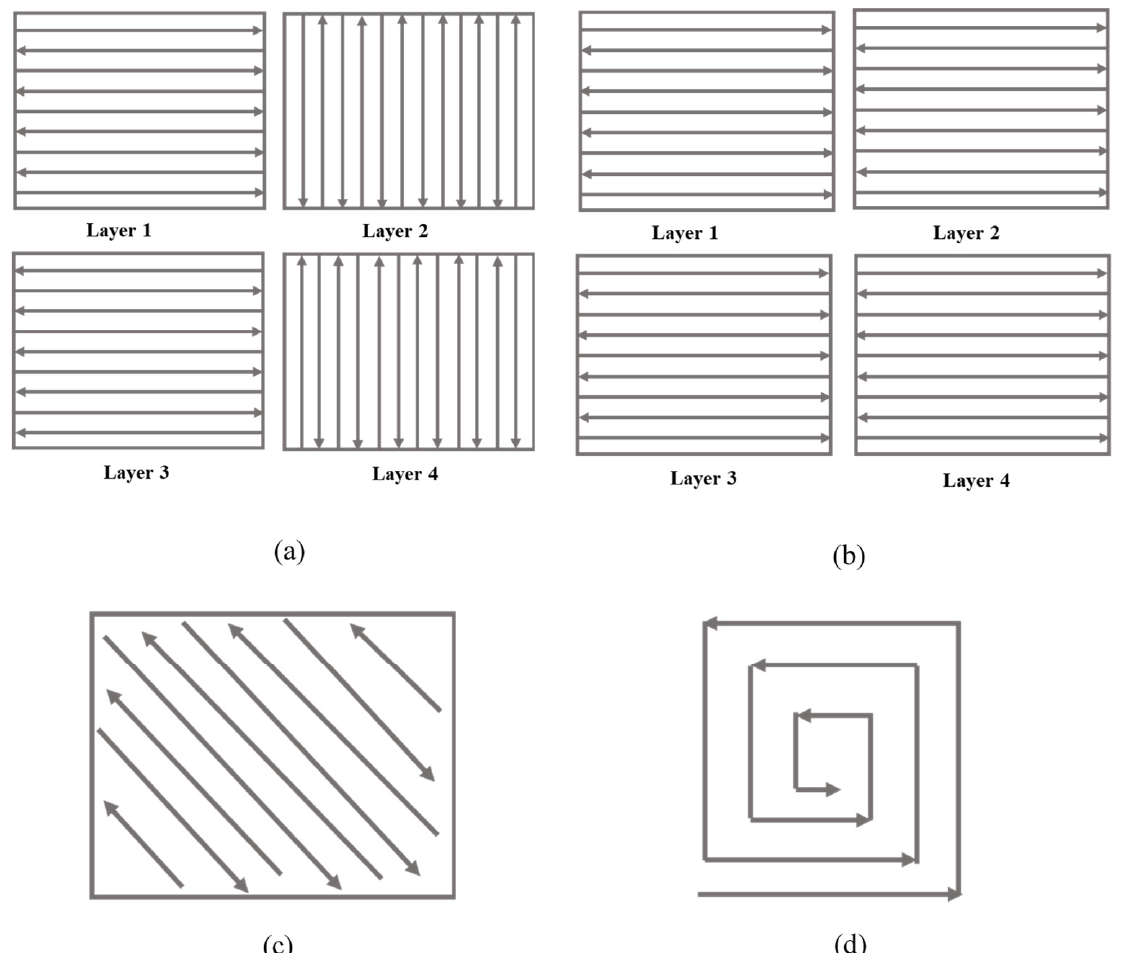
Figure 4. Various scan strategies used for the fabrication of primitive lattice layers: ( a ) Parallel with 90° rotation, ( b ) parallel with 0° rotation, ( c ) inclined at 45°, and ( d ) spiral. The samples were fabricated using a constant scan speed of 425 mm/s and a laser power of 85 W. These parameters were chosen following an extensive review work [44]. Thin-layered samples of approximately 1.0 to 1.5 mm thickness in the build direction